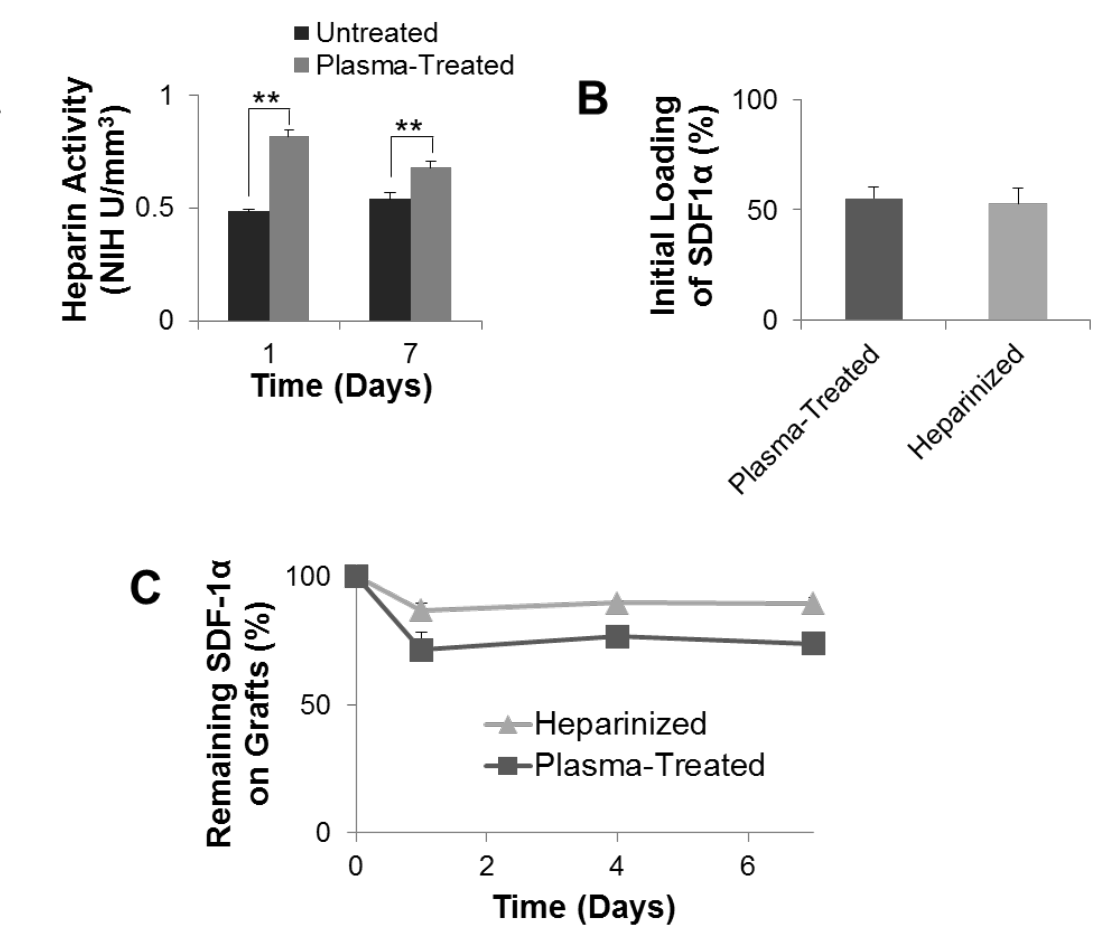
Figure 5. Quantification of heparin activity, SDF-1 α initial loading, and release. ( A ) Activity of heparin passively absorbed onto untreated and heparin conjugated plasma-treated vascular grafts. ( B ) Initial loading of SDF-1 α immobilized onto plasma-treated and heparinized vascular grafts. ( C ) The time course of SDF-1 α release from plasma-treated and heparinized grafts. ** p < 0.01, ( n = 3).